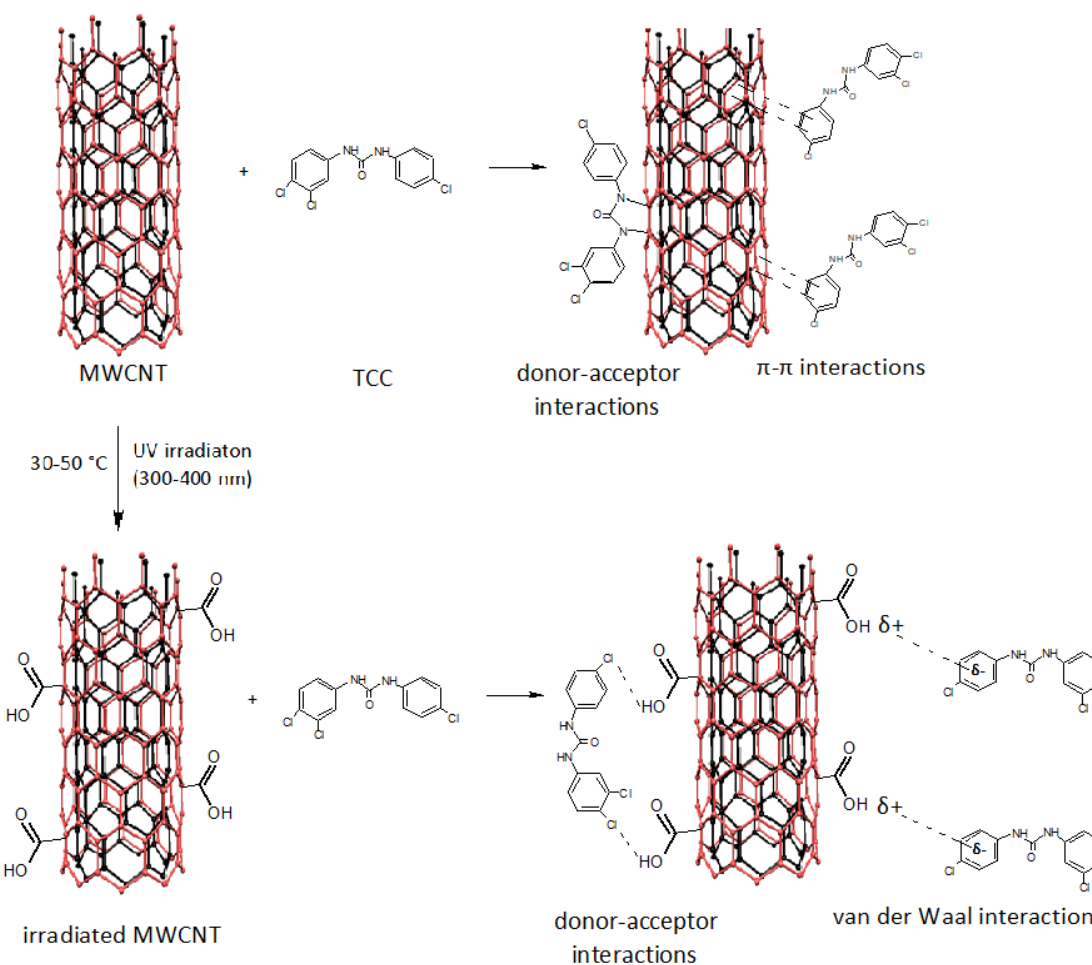
Figure 6. Proposed mechanism for the adsorption of TCC on MWCNTs.